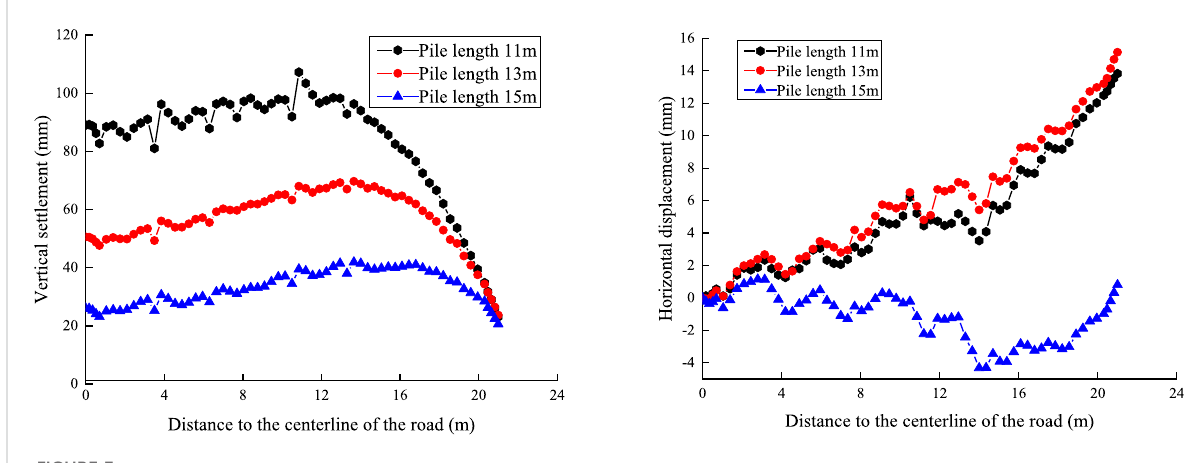
thickness did not cause signi fi cant differences in the structural